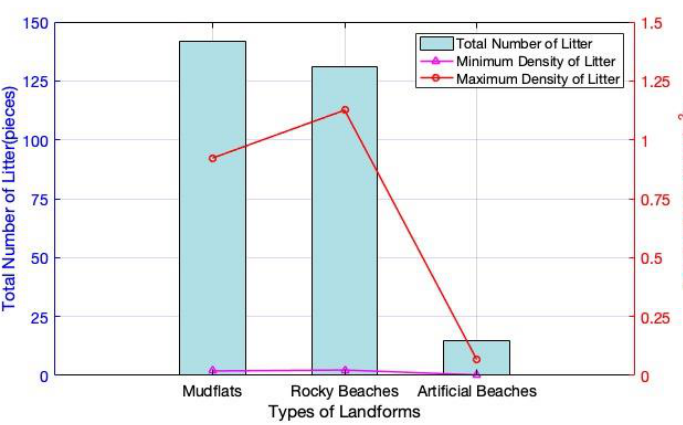
Figure 3. Total number and density of litter in different landforms.